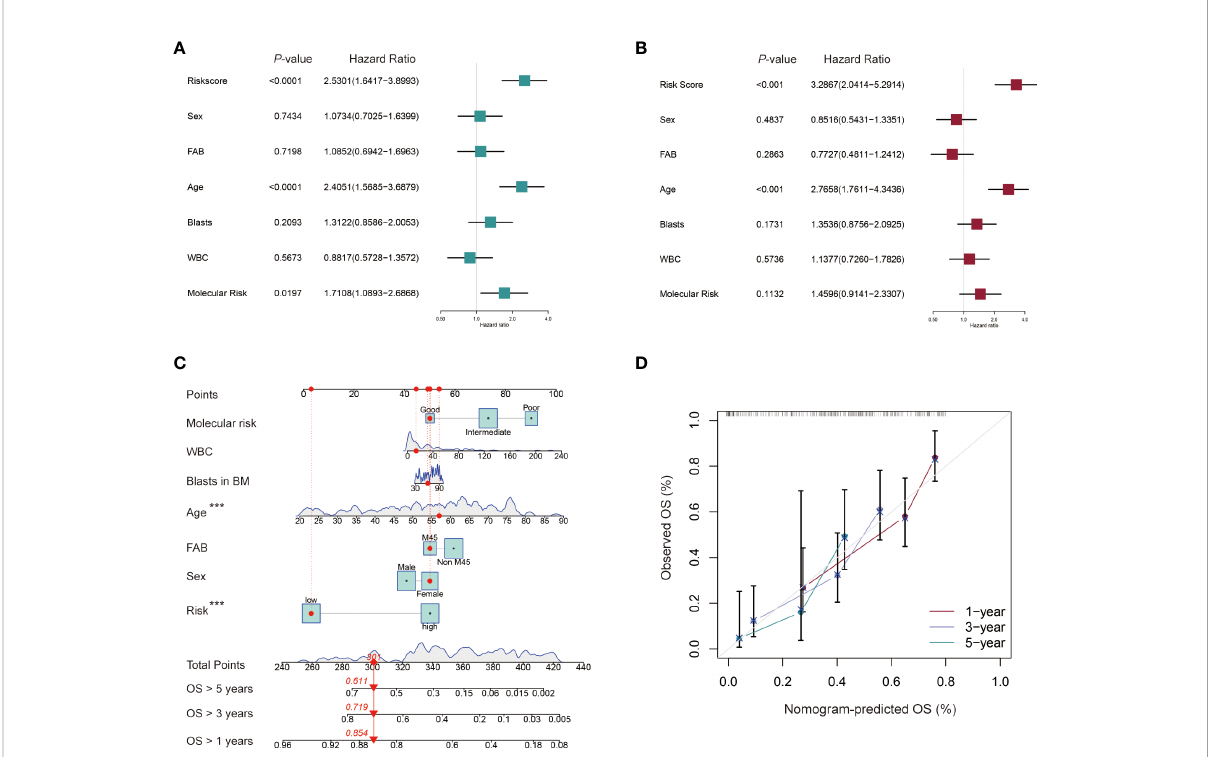
FIGURE 6 Independent prognostic role of the cuproptosis-related lncRNA signature for AML patients. (A, B) Univariate and multivariate Cox regression analysis of clinical factors including sex, French-American-British (FAB) subtype, age, blasts in bone marrow (BM), white blood counts (WBC), and molecular risk strati fi cation and risk score for OS. (C) Nomogram that integrated the risk score and clinical factors predicts the probability of the 1-, 3-, and 5-year OS. (D) The calibration curves for 1-, 3-, and 5-year